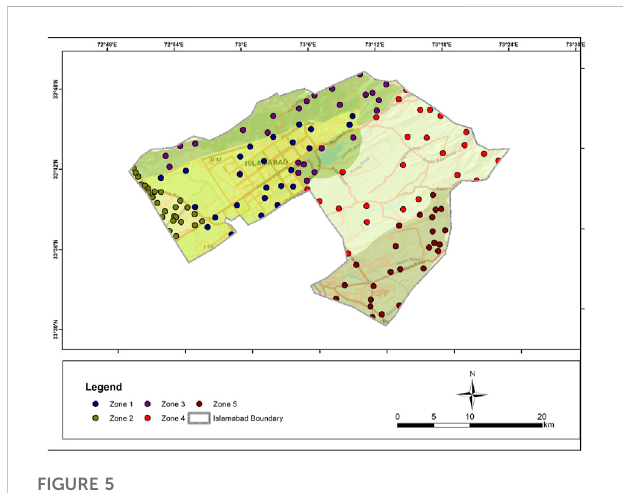
FIGURE 5 Samples location map for LST and NDVI analysis of the study area.